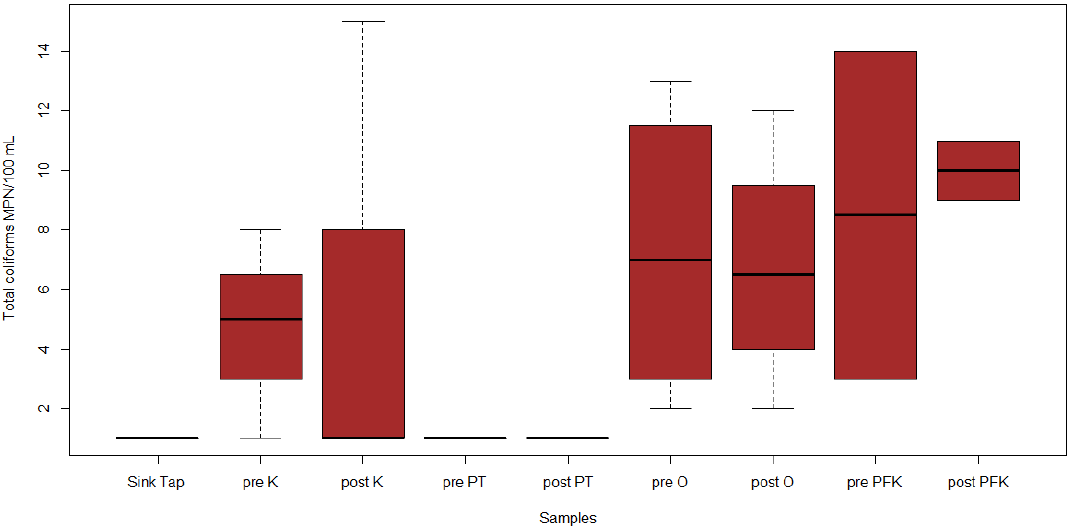
Figure 1. IDEXX total coliform concentrations (MPN / 100 mL) in collected samples (outside (O), inside kitchen (K), pressure tanks (PT), and post-filtration kitchen tap (PFK).